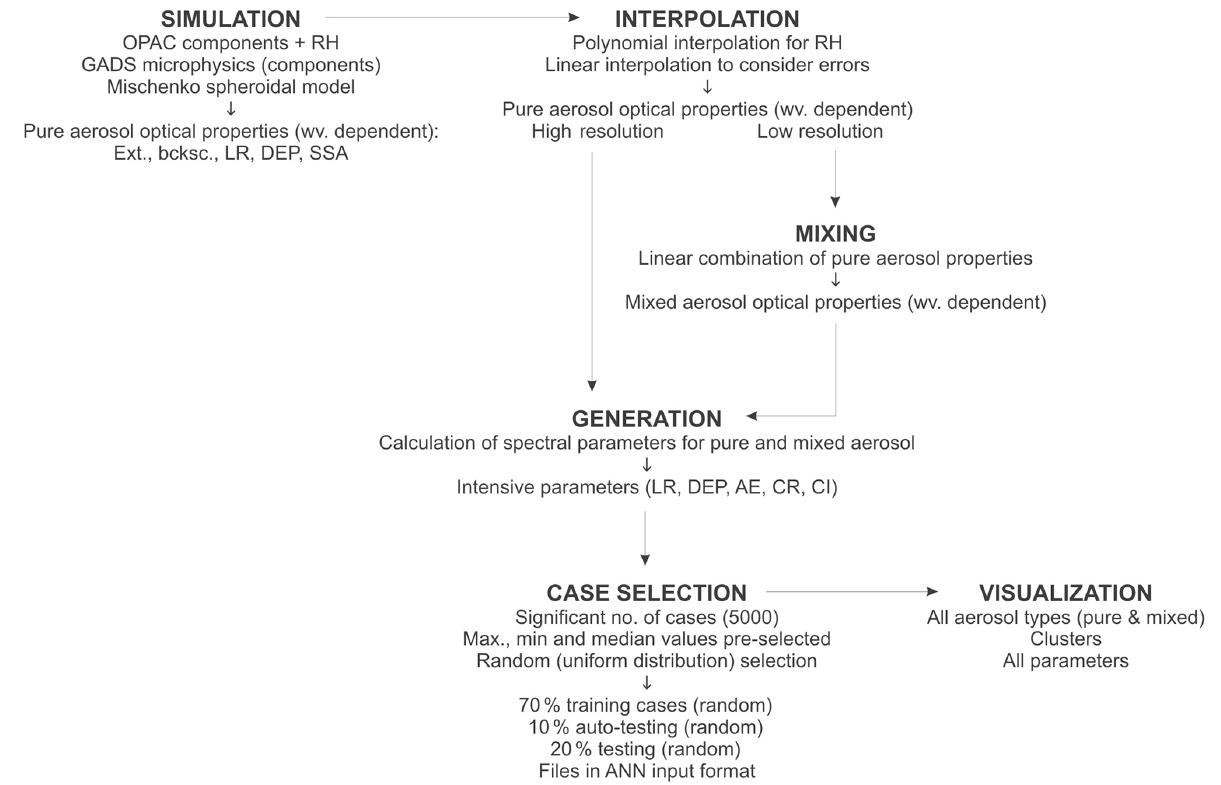
Figure 1. The generation chain of the synthetic data for the NATALI